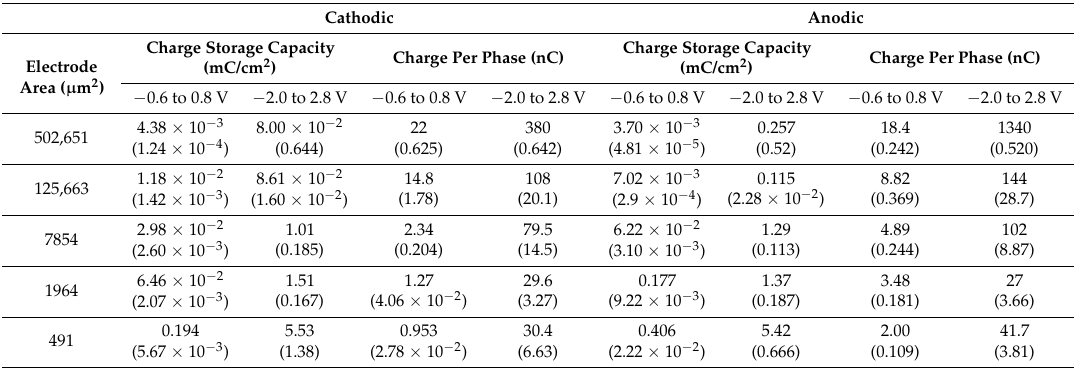
Table 1. Cathodic and anodic charge storage capacity and charge per phase